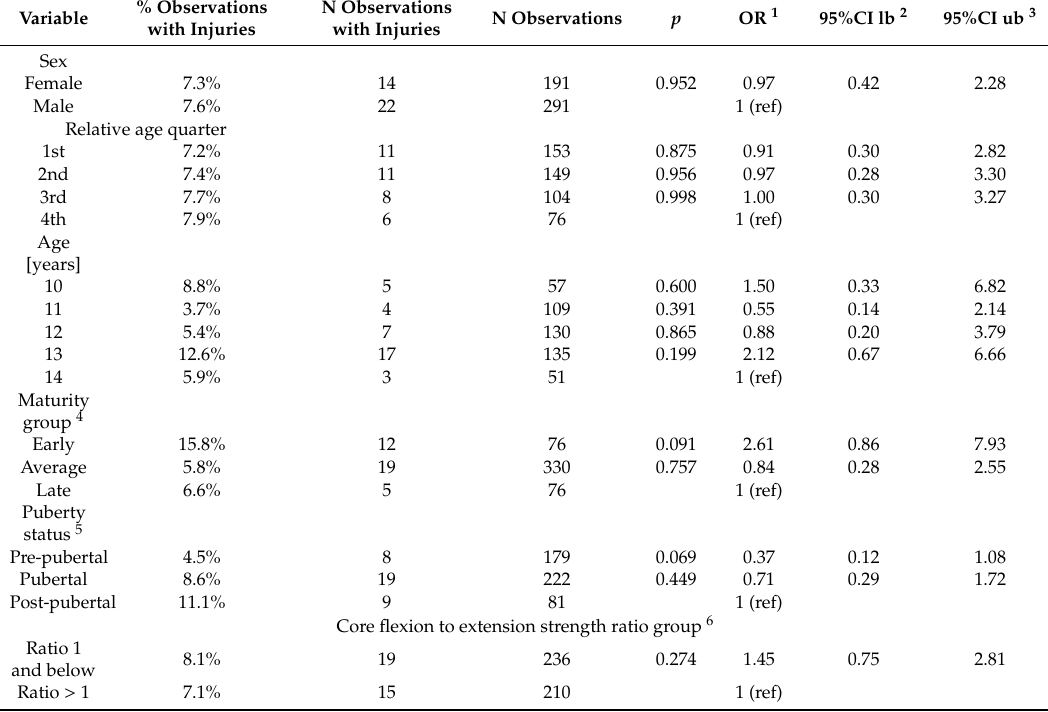
Table 4. Potential factors associated with overuse injuries according to the simple general estimating equation analysis (n = 482